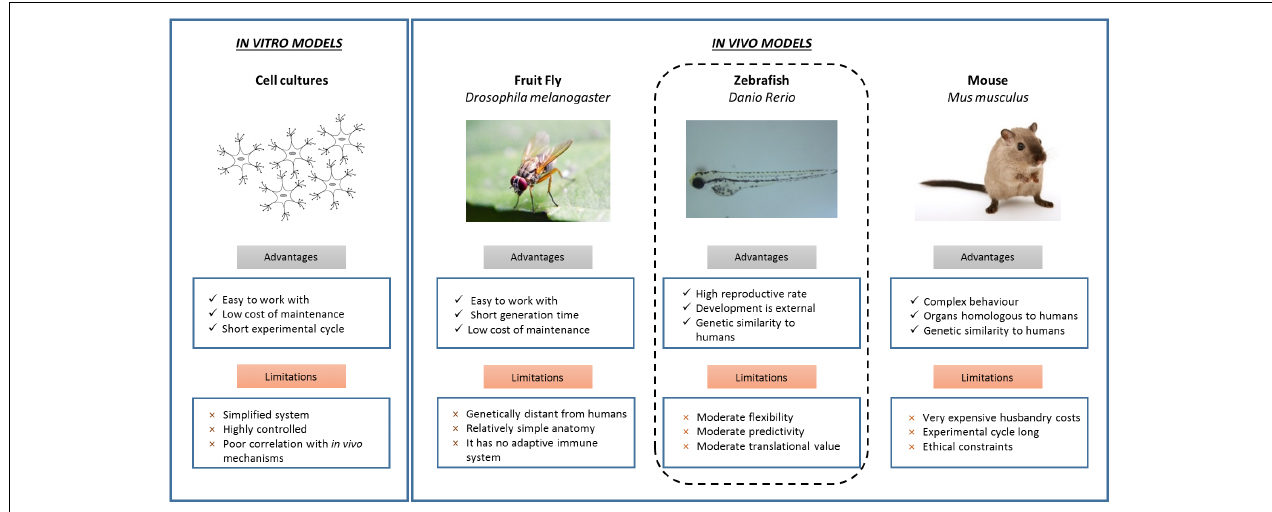
FIGURE 1 | In vitro and in vivo models for developmental neurotoxicity screening. The possible neurotoxic effects induced by different chemicals can be addressed by using several in vitro and in vivo systems. In vitro cytotoxicity models are cheap and fast, but over-simplified and provide limited and preliminary neurotoxicity data. These findings are implemented performing neurotoxicity tests on in vivo animal models. Each in vivo system possesses different advantages and limitations. In this framework, zebrafish represent excellent comparative vertebrate